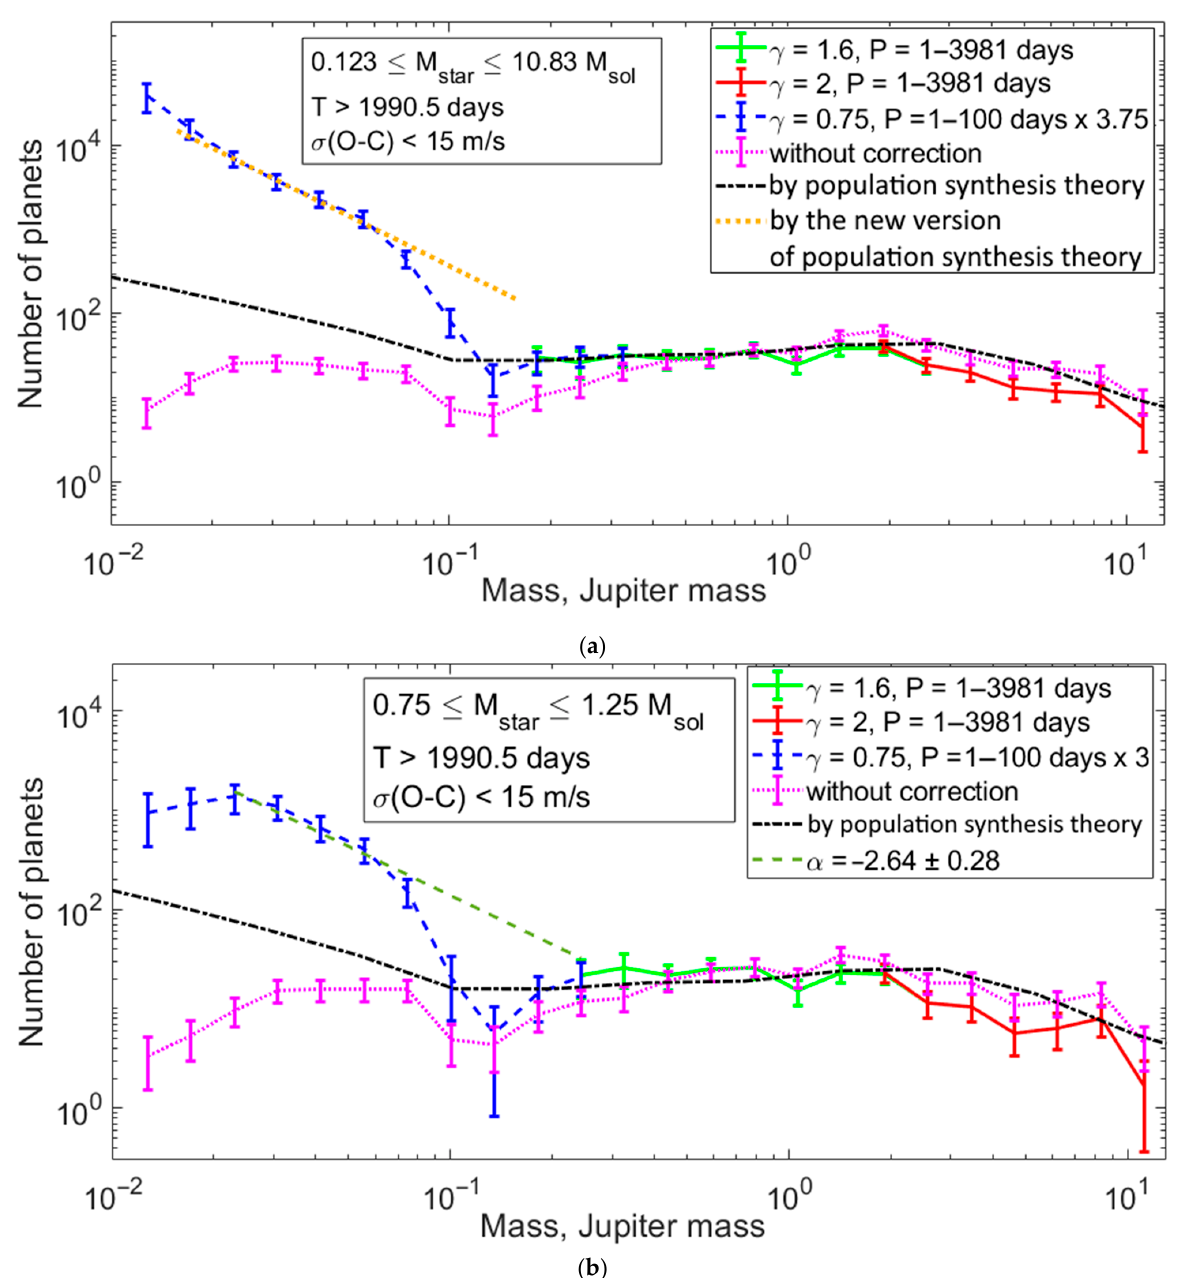
Figure 6. ( a ) The composite de-biased (via V ) distribution for the minimum masses of 598 RV planets with masses of 0.011–13 Jupiter masses that are part of systems with a noise level σ (O − C) < 15 m/s. For all sections of the distribution, δ = 2.0 was assumed. The blue solid line shows the distribution of planets with orbital periods of 1–100 days ( γ = 0.75), the blue dashed line shows the same distribution multiplied by 3.75. The green and red solid lines show the corrected distribution of planets with periods of 1–3981 days with γ = 1.6 and 2.0, respectively. The dotted magenta line shows the biased distribution of RV planets with periods of 1–10 4 days (from the NASA Exoplanet Archive [1]). The black dashed line shows the distribution of exoplanets by mass predicted by population synthesis theory [2], the orange dotted line shows the distribution of planets with masses 5–50 Earth masses according to the new version of population synthesis theory [3]. ( b ) The similar dependencies for FGK host stars (with the star masses 1.00 ± 0.25 solar